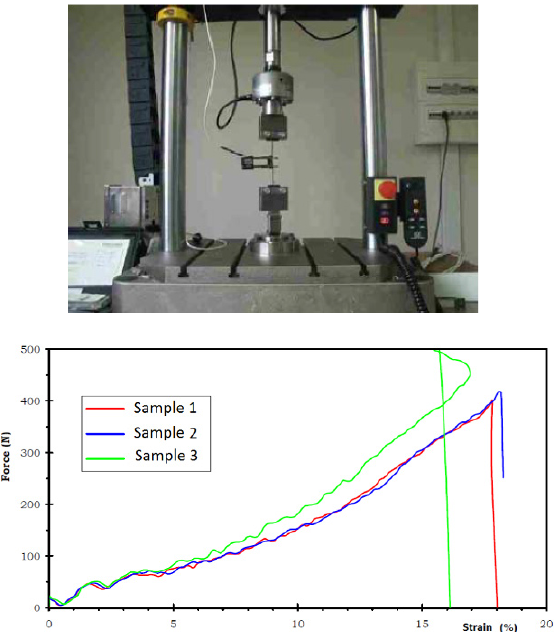
Figure 9. ExperimentaldeviceandtensiontestresponseofaCarcass ply.